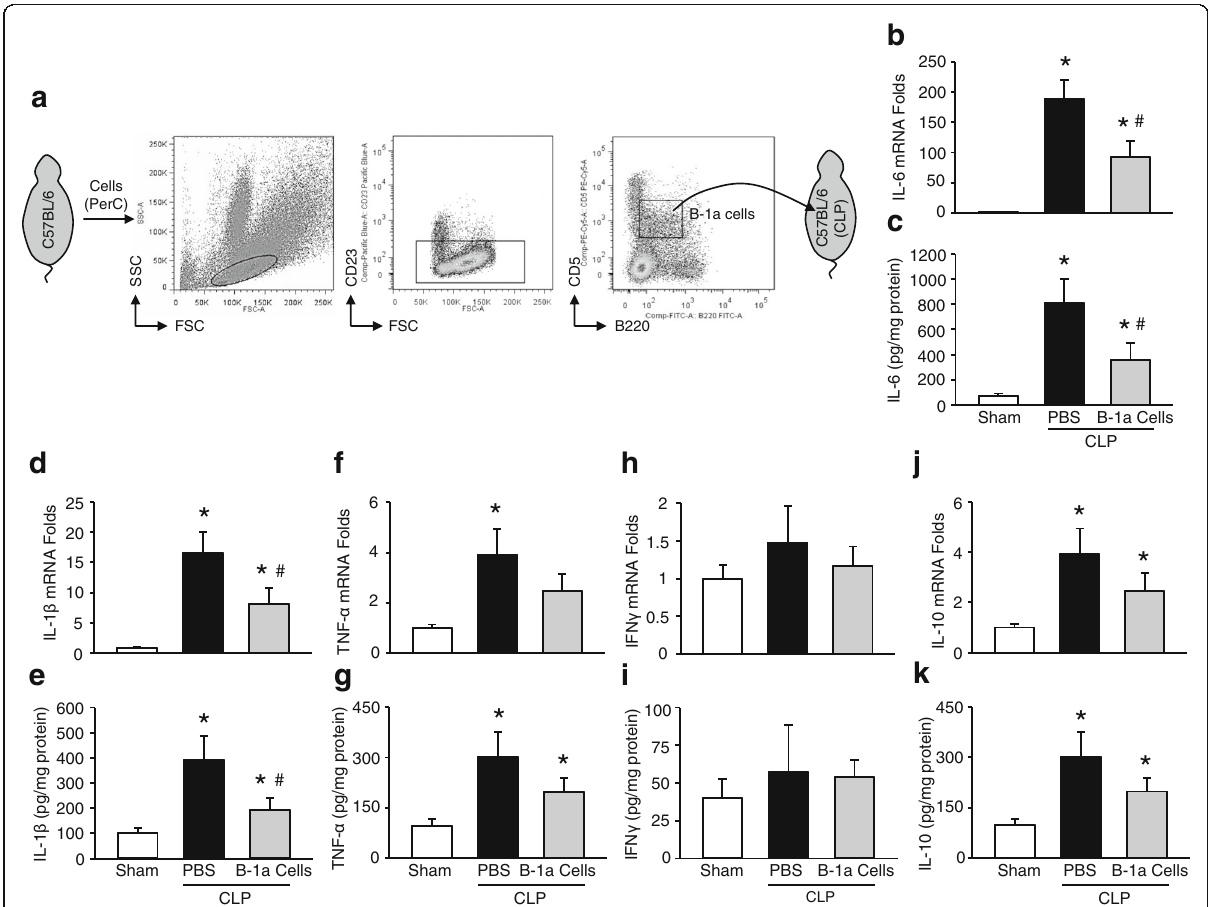
Fig. 1 Adoptive transfer of B-1a cells attenuates lung inflammation. a Peritoneal washout cells isolated from healthy mice were stained with anti- mouse Pacific Blue-CD23, FITC-B220 and PE-Cy5 Abs and subjected to sort purification by using a flow cytometry-based cell sorting system. A total of 5 × 10 5 B-1a cells suspended in 150 μ l of PBS were delivered into the peritoneal cavity of CLP mice. After 20 h, lung tissue was harvested and mRNA and protein expression of b , c IL-6, d , e IL-1 β , f , g TNF- α , h , i IFN γ and j , k IL-10 were assessed, respectively. Data are expressed as means± SE ( n = 9 mice/group) and compared by one-way ANOVA and SNK method ( * p < 0.05 vs. sham mice; # p < 0.05 vs. PBS-treated CLP mice). CLP, cecal ligation and puncture; IL,